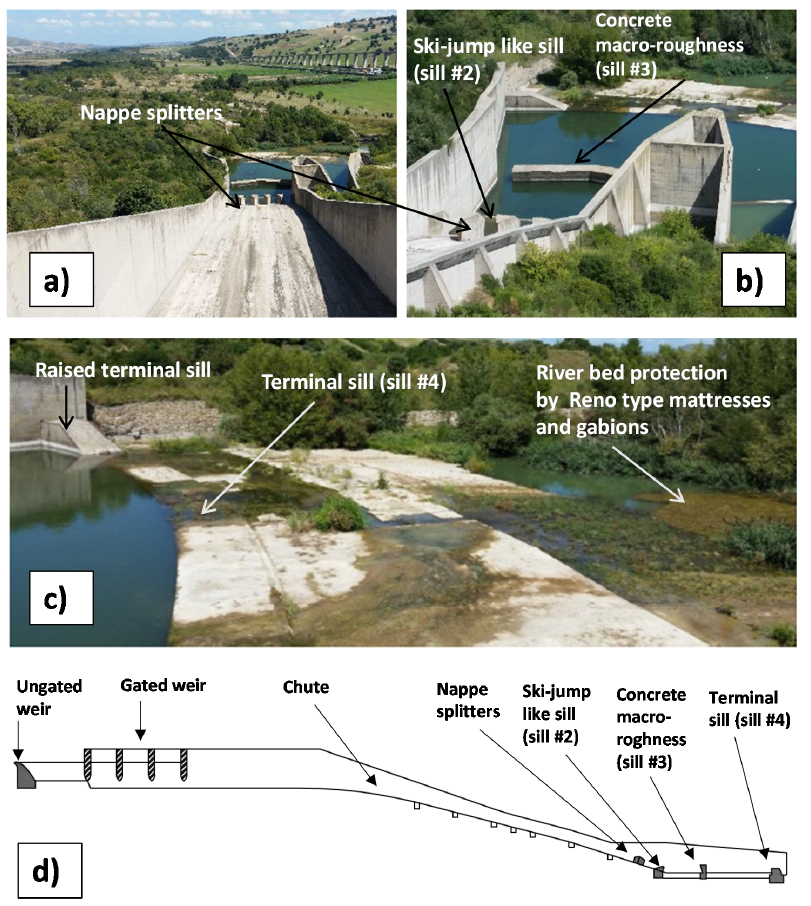
Figure 3. ( a ) Chute; ( b ) stilling basin; ( c ) terminal sill and river bed protection; ( d )